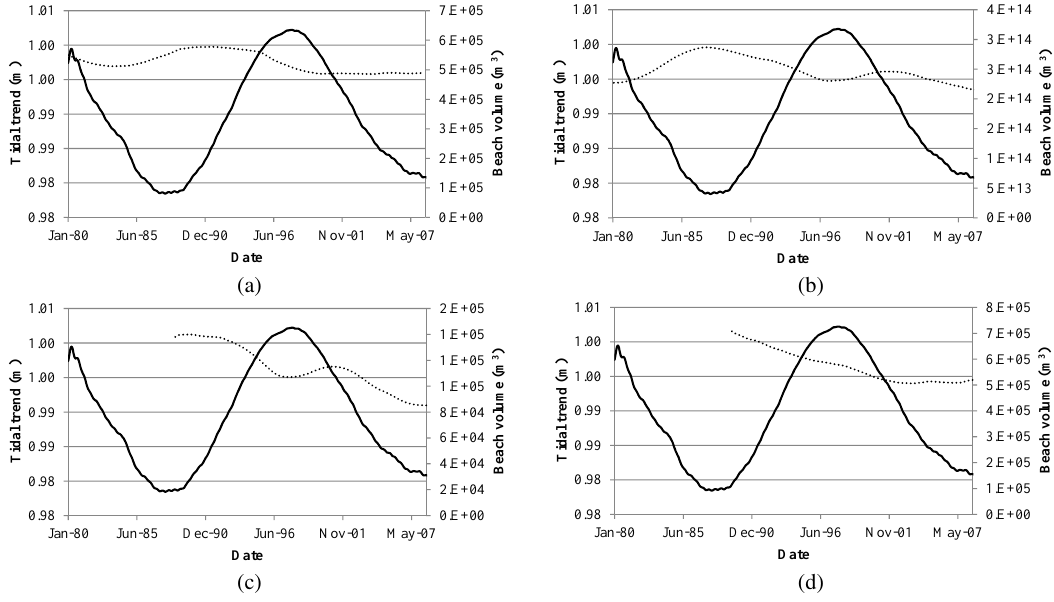
Table 5. Annual rate of change of storm attributes with 95% confi- dence bounds